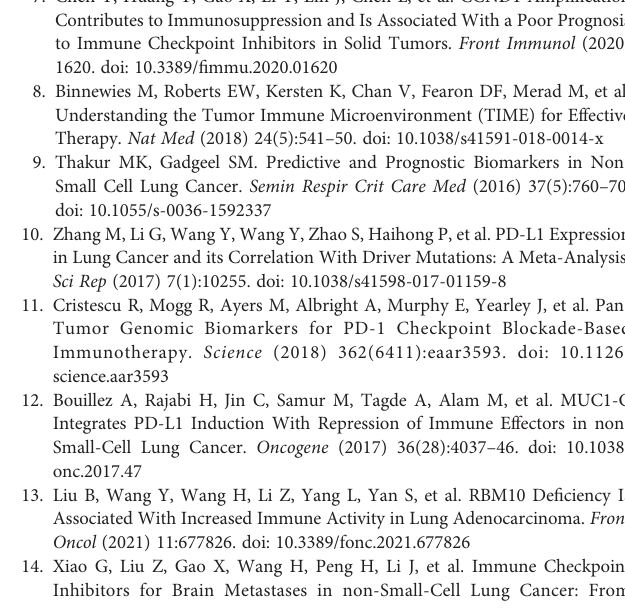
Supplementary Figure 3 | Prediction performances of the C3 IS and three reported models. Concordance index showing measure of concordance of predictor with OS and DFS between C3 IS and three reported prognostic models in the combined four GEO cohorts (n = 901) (A – B) , GSE37745 (n = 106) (C) , GSE50081 (n = 127) (D) , GSE68465 (n = 442) (E), and GSE31210 (n = 226) (F). Supplementary Figure 4 | The prognoses of stage I TCGA LUADpatients were not signi fi cantlydifferentbytheimmunesubtypes. (A) Overallsurvivalbyimmunesubtypesin the stage I TCGA LUAD cohort. Log-rank P-value was calculated among subgroup strati fi cation. (B) Overall survival by immune subtypes in the stage I TCGA LUADcohort. Log-rank P-value was calculated between every two subgroups. (C) Distribution of stagesintheTCGALUADcohortbyimmunesubtype. (D) Sankeydiagramofstageand immune subtypes in the TCGA LUAD cohort. Supplementary Figure 5 | Differential expression of immunomodulatory genes between C3 IS and other ISs. The mRNA expression (log2FPKM) for 75 immunomodulator genes between the C3 (in fl ammatory) and other ISs in the TCGA LUAD cohort. Adjusted P-value was calculated for immune checkpoints. Supplementary Figure 6 | Differential expression of pathways between C1 (wound healing)/C2 (IFN- g dominant) vs. C3 (in fl ammatory) immune subtypes in LUAD patients. Heatmap showing the details of different upregulation of ssGSEA of HALLMARK (A) and KEGG (B) pathways among the C1 (wound healing) and C3 (in fl ammatory) immune subtypes in the TCGA LUAD cohort. Heatmap showing the detailsofdifferentupregulationofssGSEAofHALLMARK (C) andKEGG (D) among the C2 (IFN- g dominant) and C3 (in fl ammatory) immune subtypes in the TCGA LUAD cohort. The result is expressed according to the median z-scores of the ssGSEA score of pathways. Supplementary Figure 7 | Immune and stromal cell populations between the other ISs (A)/C2 (IFN- g dominant) (B) and C3 (in fl ammatory) immune subtypes in the TCGA LUAD cohort. Immune and stromal signatures were estimated by CIBERSORT. And the P-value was calculated by the Wilcox